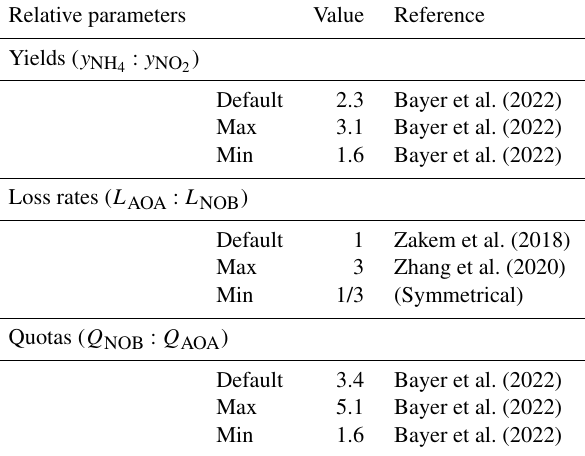
Table 1. Relative parameter values used to describe marine AOA and NOB functional types. See Table A1 for absolute